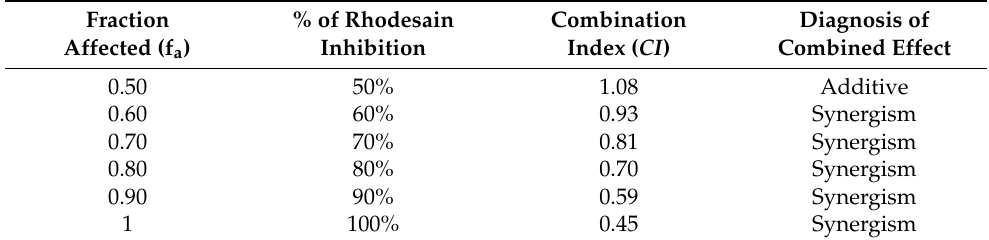
Table 2. Combination index at several f a